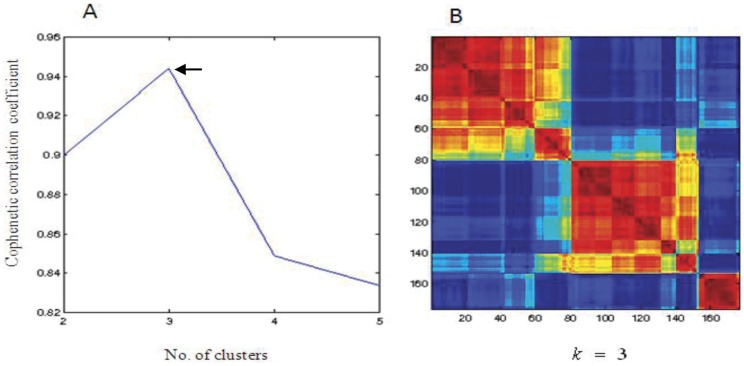
Unsupervised clustering using NMF.(A). Cophenetic correlation coefficients associated with different numbers of clusters . Y-axis is the cophenetic correlation coefficient (); x-axis is the number of clusters. The arrow displays the  at . (B). Heat map of reordered consensus matrix for . Dark blue indicates samples never assigned to the same cluster, and red indicates samples always assigned to the same cluster.